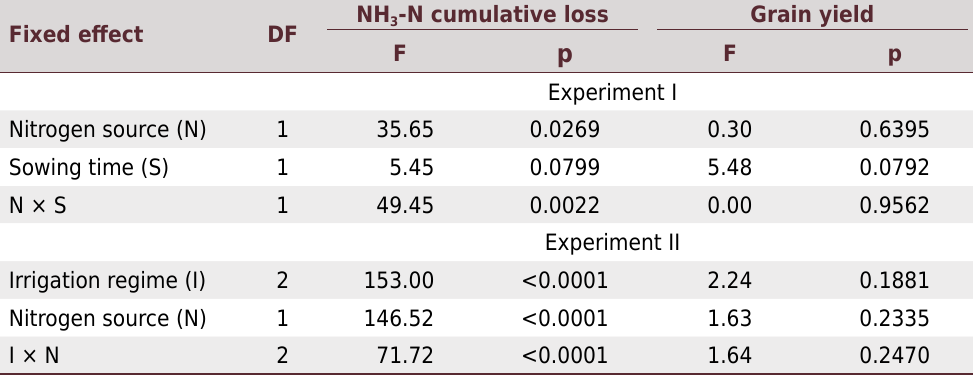
Table 1. Analysis of variance of the results of Experiments I and II